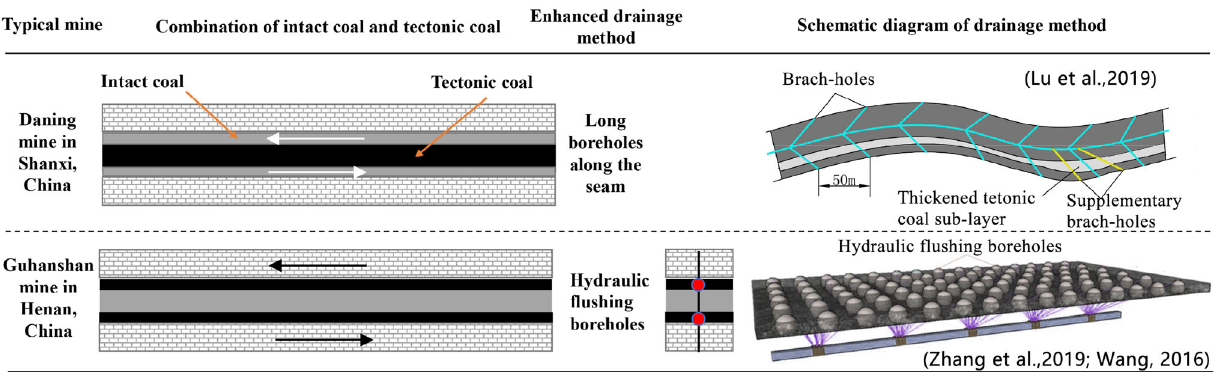
Fig. 7 Schematic diagram of drainage methods used in Daning Coal Mine and Guhanshan Coal Mine, China (Lu et al. 2019a, b; Wang 2016; Zhang et al. 2017)